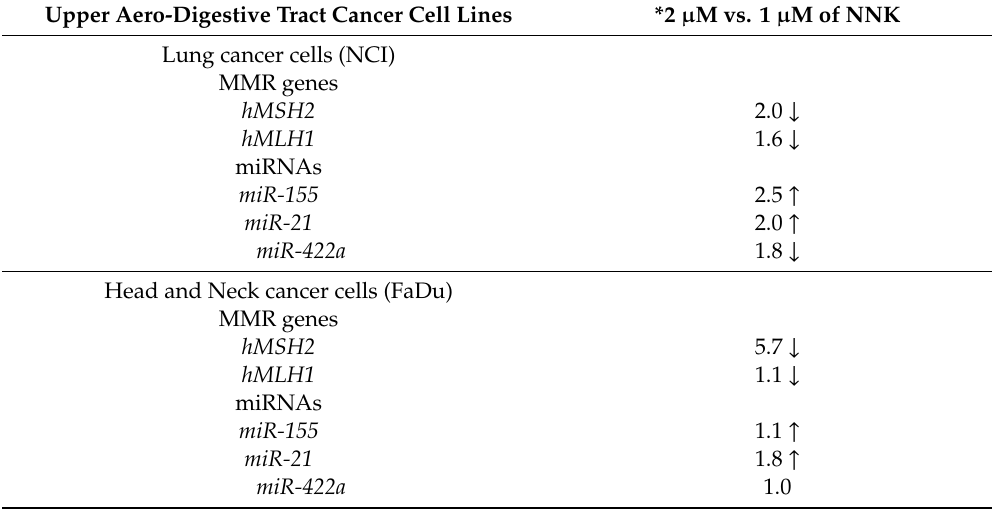
Table 1. MMR mRNA and miRNA expression changes produced in Lung (NCI) and Head and Neck (FaDu) cancer cells exposed to high (2 µ M) versus to low (1 µ M) dose of NNK. Upper Aero-Digestive Tract Cancer Cell